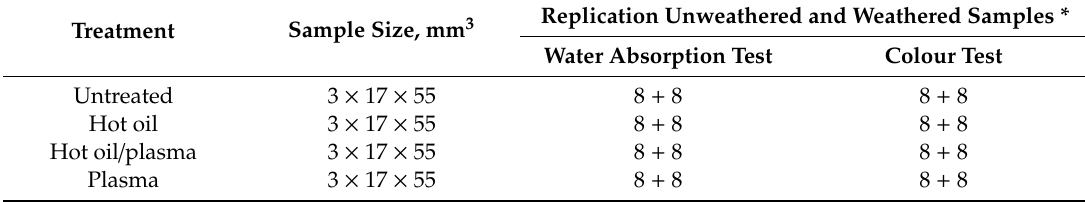
Table 2. Treatments, sample sizes and replication for an experiment that examined the e ff ects of hot-oil modification and plasma treatment on the water absorption and colour (CIE L value) of blue-stained lodgepole pine samples coated with a white acrylic paint system and exposed to natural weathering for 18 months (unexposed samples acted as a